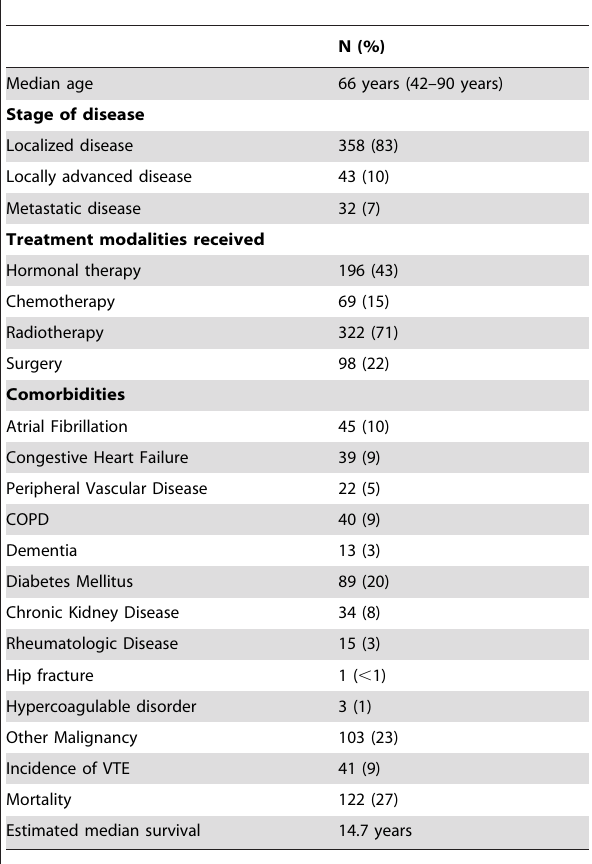
Table 1. Demographics and clinical characteristics of patient